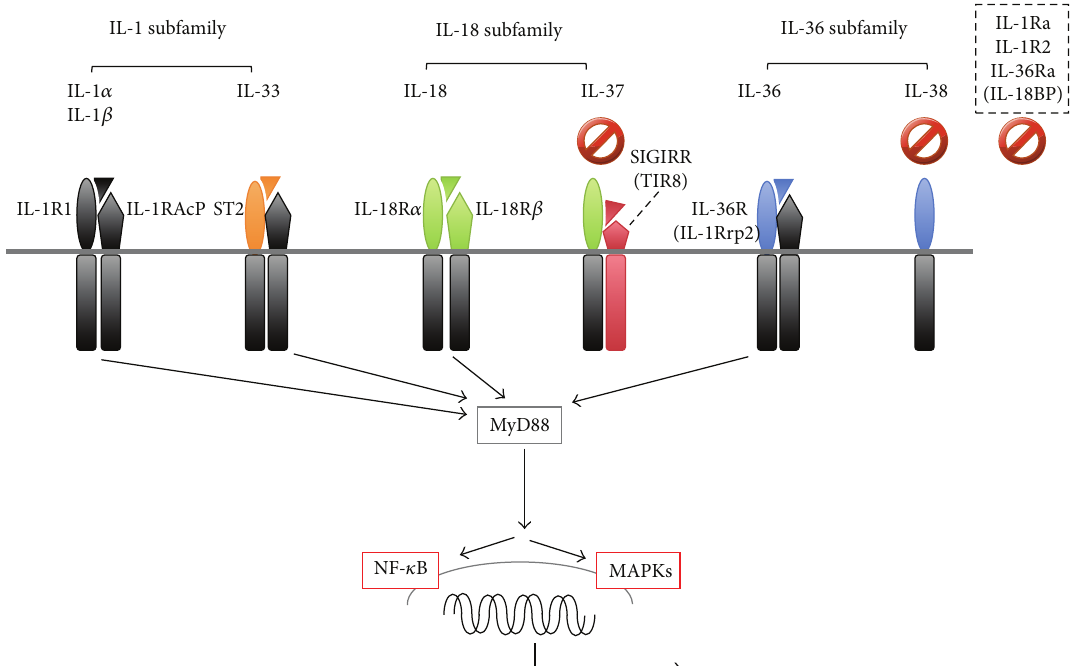
Figure 1: IL-1 family agonists and antagonists. The IL-1 family is divided into three subfamilies based on the length of the N-terminal pro- pieces. The IL-1 subfamily consists of IL-1 𝛼 , IL- 𝛽 , IL-1 receptor antagonist (IL-1Ra), and IL-33. The IL-18 subfamily is composed of IL-18 and IL-37. IL-36 𝛼 , IL-36 𝛽 , IL-36 𝛾 , and IL-38 belong to the IL-36 subfamily. The receptor for each IL-1 family cytokine is a heterodimer of the proper or common subunits. IL-1R1, ST2, IL-18R 𝛼 , and IL-36R are ligand-binding subunits, whereas IL-1R accessory protein (IL-1LRAcP), IL-18R 𝛽 , and SIGIRR (TIR8) are signaling subunits. Upon engagement of the binding subunits with the corresponding ligands, they recruit the corresponding signaling receptor subunit, which, except in IL-37 signaling, ultimately translocates nuclear factor- (NF-) 𝜅 B to the nucleus and activates MAPKs such as p38 and JNK. IL-38, IL-1Ra, IL-18-binding protein (IL-18BP), and IL-36Ra inhibit IL-36, IL-1, IL-18, and IL- 36 signaling, respectively. IL-37 inhibits the signal pathways of the innate and acquired immune responses via mechanisms that are poorly identified. IL-1R2 acts as a decoy receptor for IL-1 𝛼 and IL-1 𝛽 . Stop signs indicate proteins that inhibit corresponding ligand signaling or those thatnegativelyregulateothersignalpathwaysaswell.JNK:c-jun-N-terminalkinase;MAPK:mitogen-activatedproteinkinase;SIGIRR:single immunoglobulin IL-1-related receptor; ST2: suppression of tumorigenicity